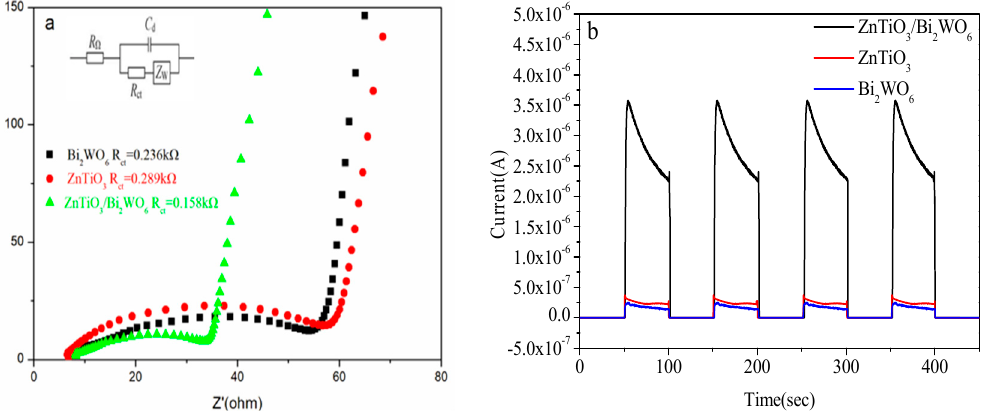
Figure 5. ( a ) Impedance spectrum of the prepared catalyst; ( b ) transient photocurrent curve of the prepared catalyst.